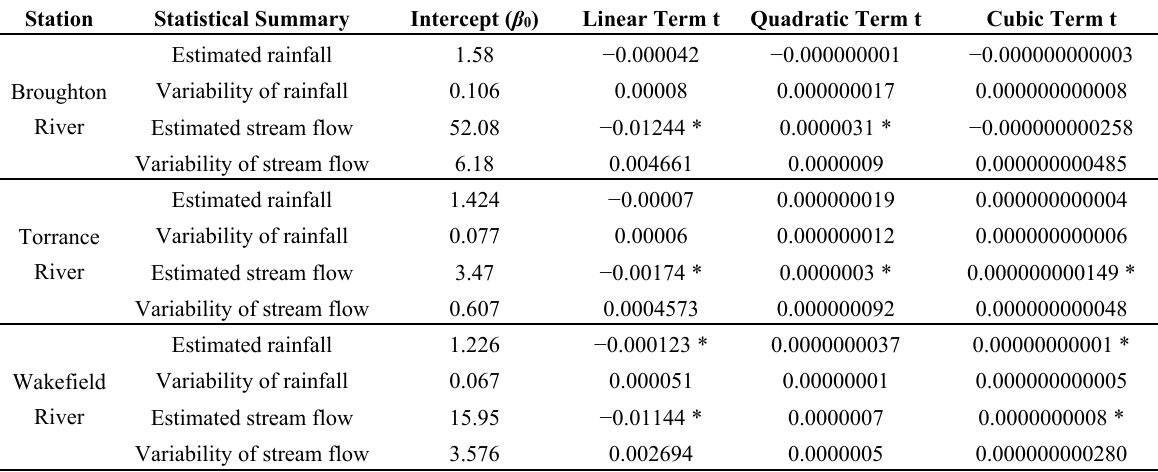
Table 4. Estimated coefficients of rainfall and stream flow variability from 1990 to